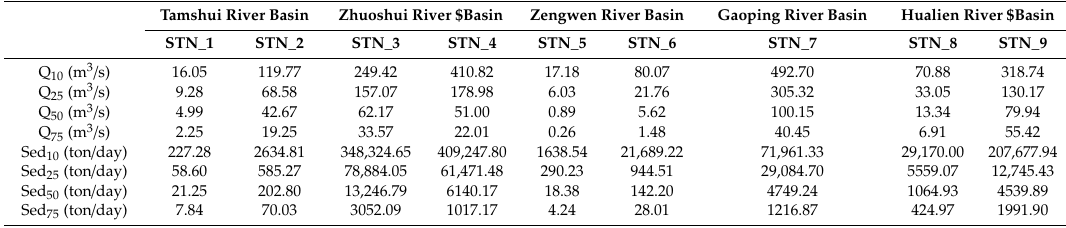
Figure 5. Monthly discharge and sediment export. ( a ) streamflow; ( b ) sediment load. Table 7. Flow duration curve analysis at nine gauging